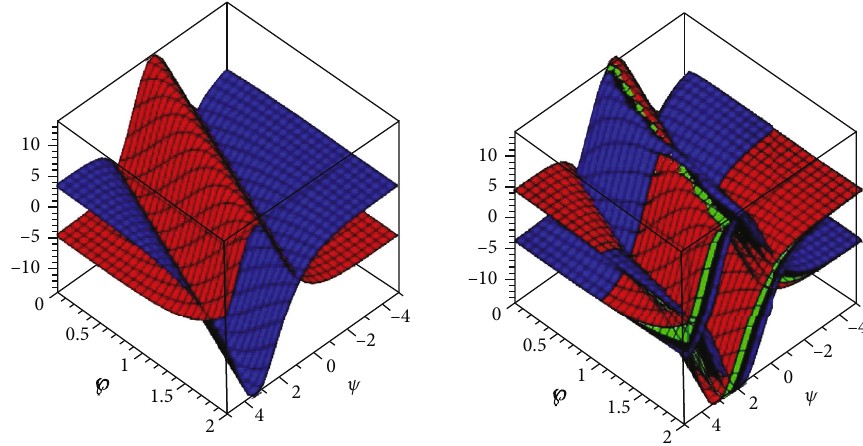
Figure 1: (a) 3D upper and lower fuzzy branch plots of the approximate series result and (b) the di ff erent fractional order of ς